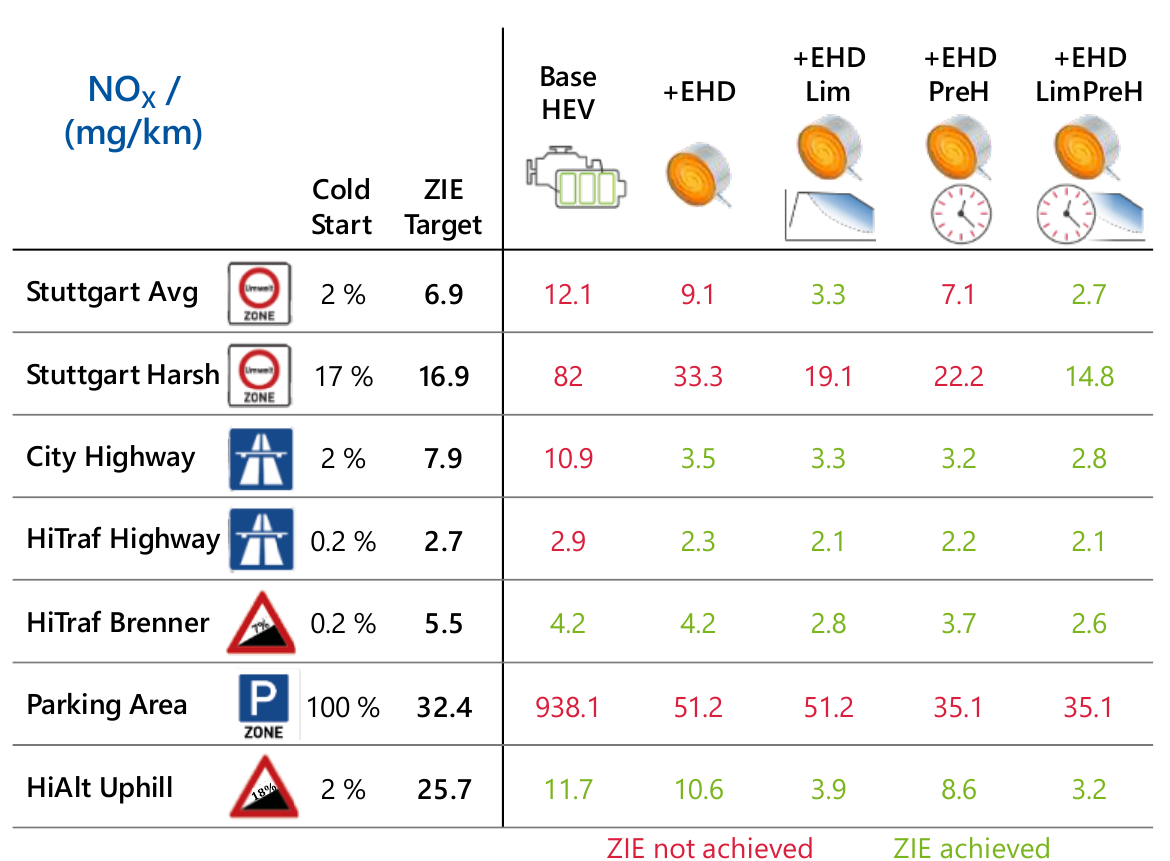
Figure 14. Electrical heater disk technologies under Zero-Impact Emissions test conditions.